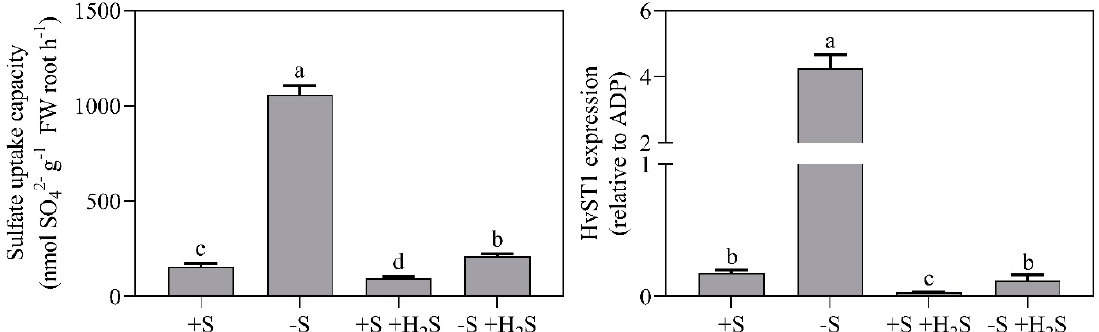
Figure 5. Sulfate uptake capacity and expression of the HvST1 transporter in barley roots in the presence and absence of a H 2 S and sulfate supply. For experimental details, see the legend of Figure 1. Data represent the average of 7 (sulfate uptake capacity) and 3 (HvST1 expression) measurements with 3 plants per measurement ( ± SD). Significant di ff erences between treatments are indicated with di ff erent letters ( P ≤ 0.05; two-way ANOVA; Tukey’s HSD test as a post-hoc test).